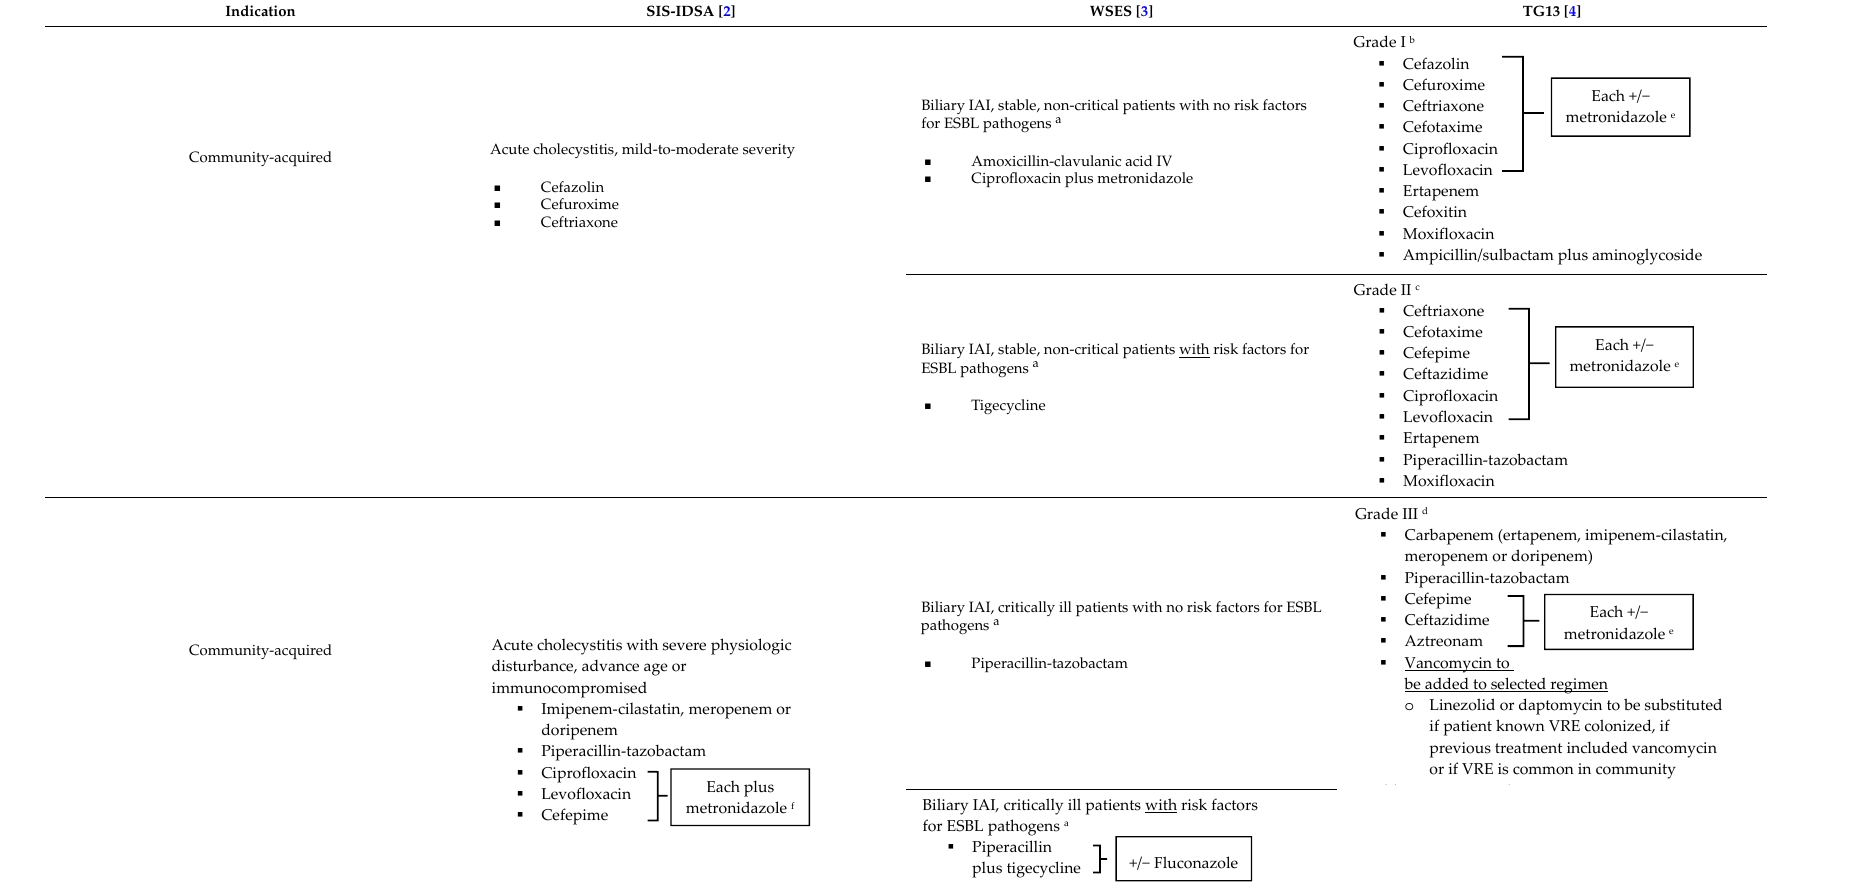
Table 1. Antimicrobial treatment recommendations for cholecystitis in adults.